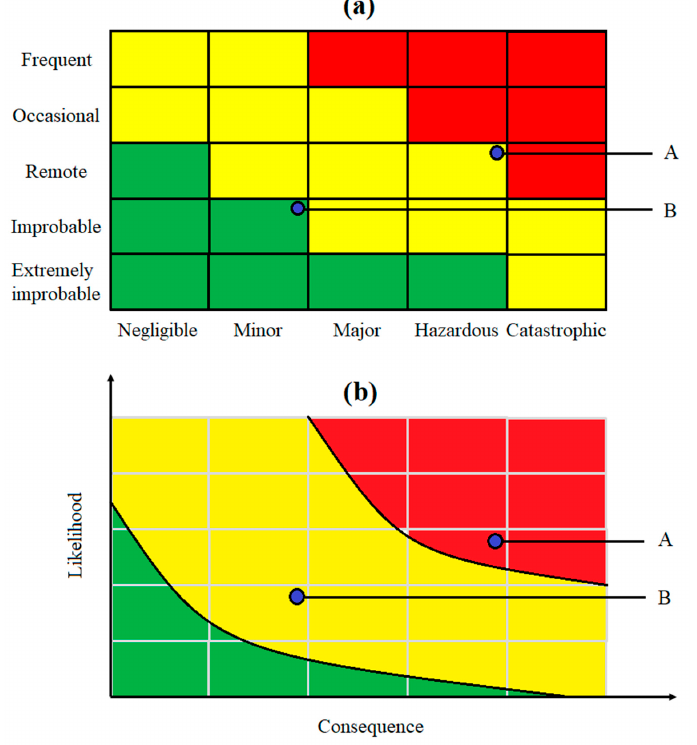
Figure 2. An example of ( a ) the TRM and ( b ) the RRM.